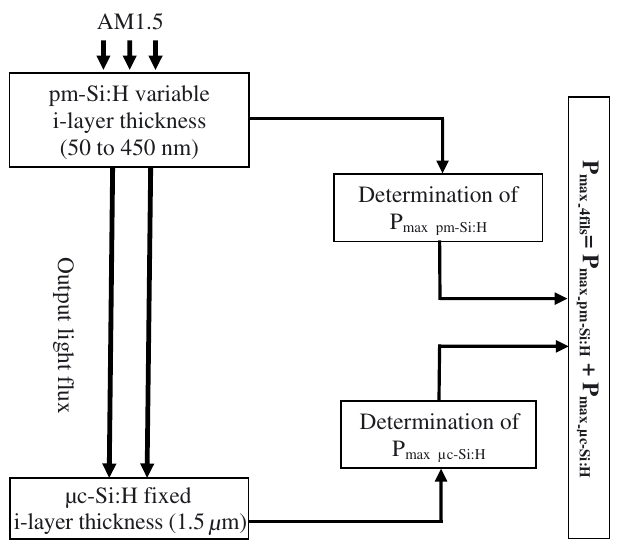
Fig. 4. Simulation steps for a four-wire tandem